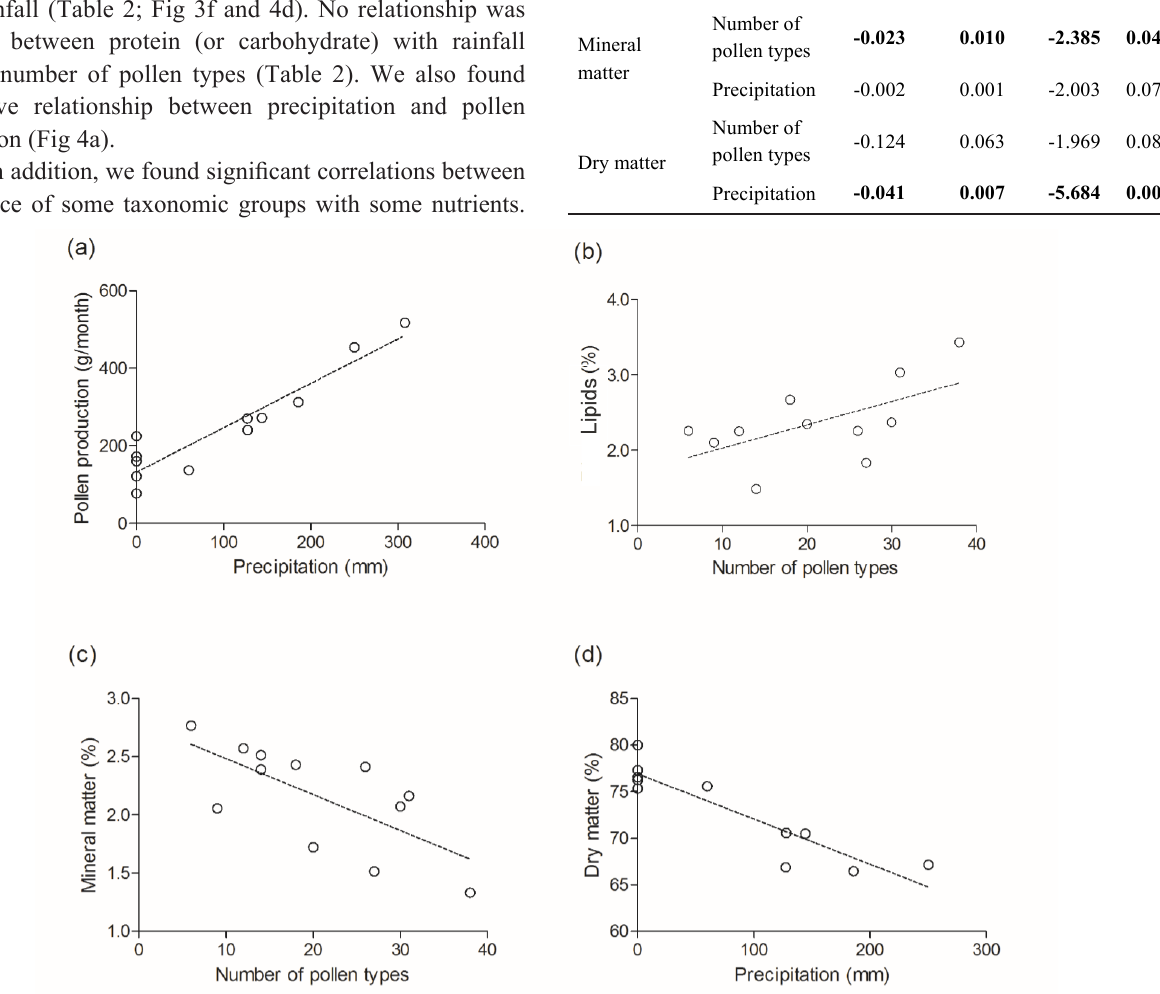
Fig 4 . Spearman correlation between dependent variables. ( a ) Annual production of bee pollen and rainfall. ( b ) Lipids and number of pollen types ( c ) Mineral matter and pollen types ( d ) Dry matter and